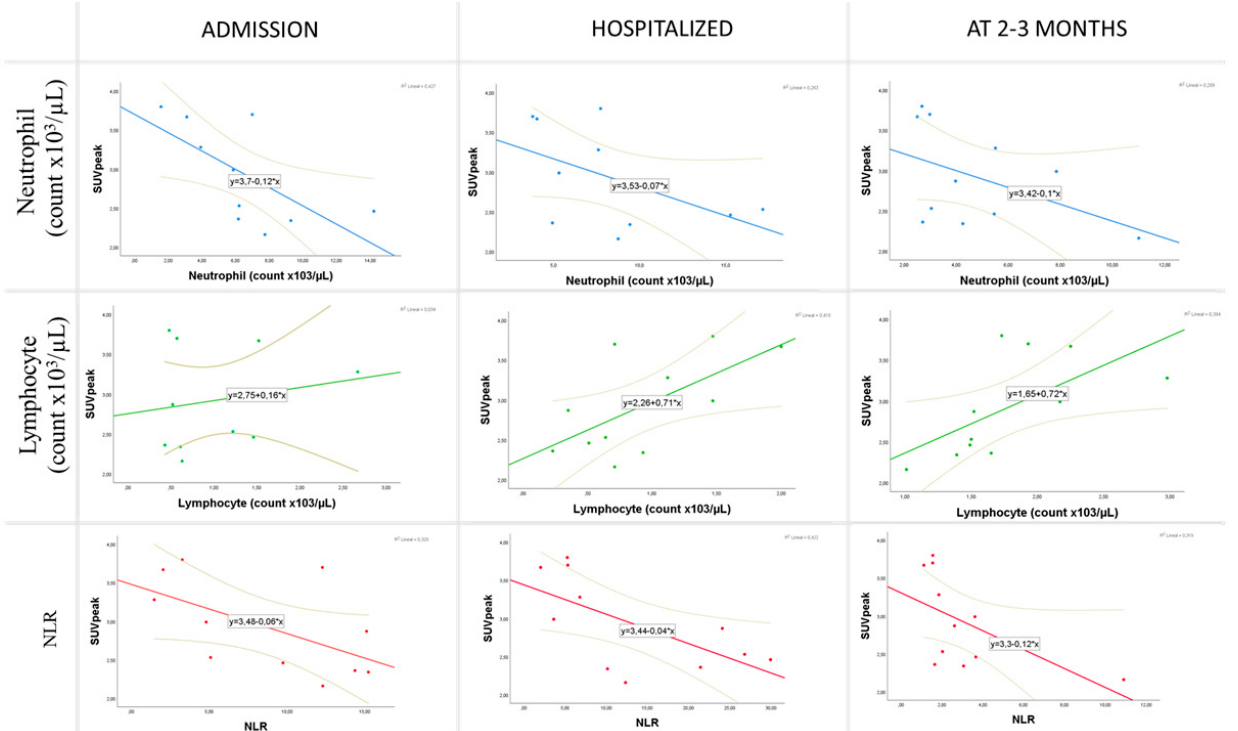
Figure 3. Scatter plot matrix. Correlation of the SUVpeak of the target lesion with neutrophil and lymphocyte counts and NLR at admission, during hospital stay, and at 2–3 months post-discharge. 3.3. Correlation of Volumetric [ 18 F]FDG-PET/CT Parameters with Respiratory Function Parameters